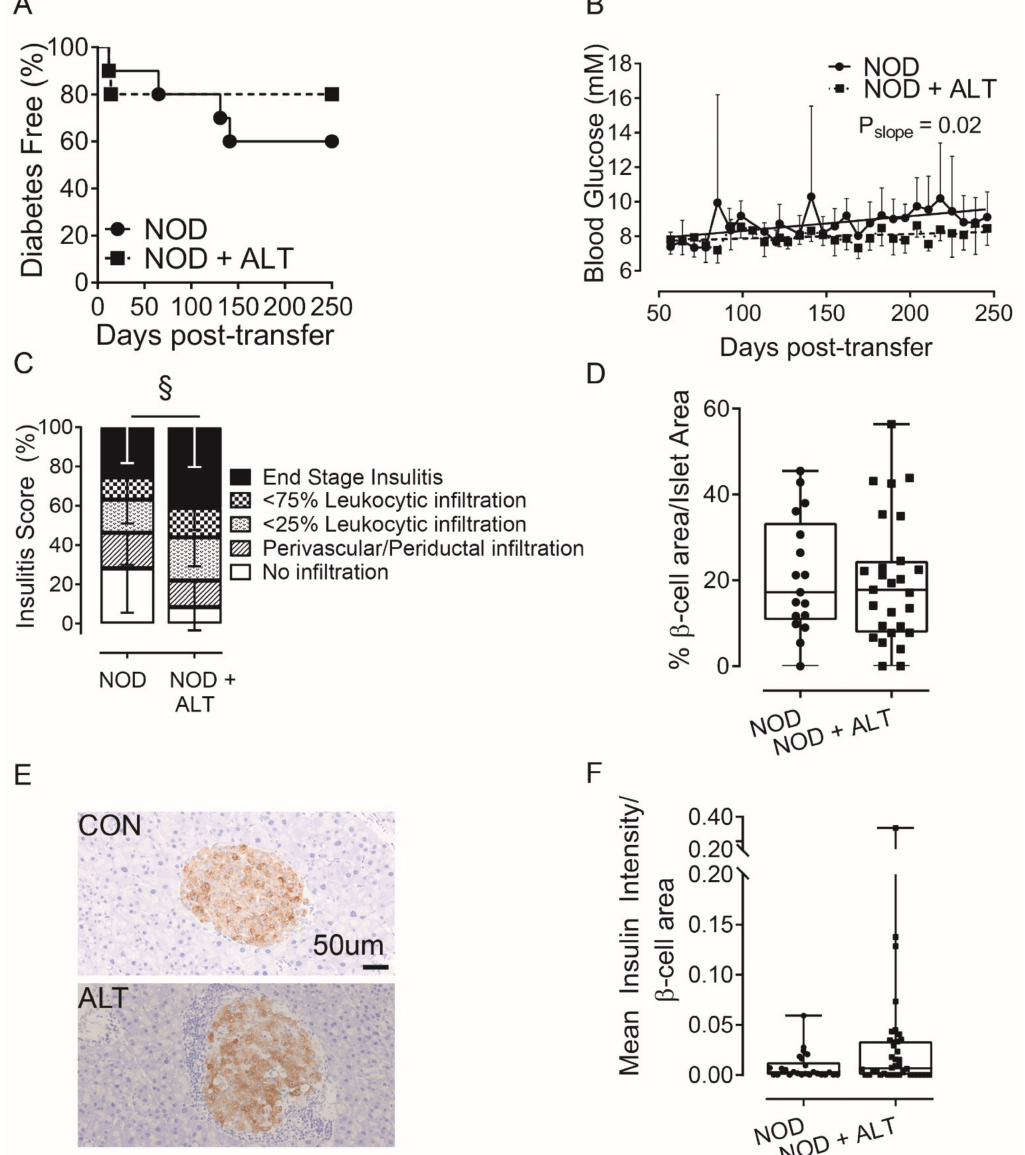
Figure 2. Alagebrium chloride delays diabetes development following adoptive transfer of G9C8 CD8 TCR transgenic cytotoxic lymphocytes. Diabetogenic splenocytes from NOD G9C8 CD8 TCR transgenic donors pre-primed with the aa15–23 of the insulin B chain (1 × 10 7 cells), were transferred into non-diabetic NOD ShiLt recipients ( n = 10/group; day 80 of life). NOD ShiLt recipients were pre-treated for 30 days with (NOD + ALT, 1 mg/kg/day, s.c; (cid:4) , dashed line) or without alagebrium chloride (NOD, • , solid line). The recipient mice were monitored daily, tested for blood glucose and diabetes diagnosed by two consecutive blood glucose measurements > 15 m · mol/L and followed until diabetes diagnosis or until study end (day 250). ( A ) Diabetes incidence in NOD ShiLt recipients post-transfer of G9C8 cells. ( B ) Linear regression of non-fasting blood glucose concentrations over time, difference of slopes p = 0.02. ( C ) Pancreatic immune cell infiltration at day 250 ( n = 6–8 mice/group), shown as mean percentage of islets with no infiltrate (white), perivascular/periductal infiltrate (striped), <25% infiltrate (arrowhead), <75% infiltrate (checkerboard) or end stage insulitis (black) of untreated splenocytes (CON; circles) or Alagebrium-treated splenocytes (ALT; squares) § p <0.0001, chi-square test. ( D ) β -cell area, determined from insulin IHC staining in ( E ) Representative images of islets detected with anti-insulin antibody in pancreatic sections taken from untreated (CON) or treated mice (ALT), scale bar = 50 µ m. ( F ) Pancreatic expression of insulin ( n = 26–40 sections/group, n = 2–39 islets/section, n = 6–8 mice/group, 5 µ m sections, 96 µ m apart. Data reported as either mean ± SD or box and whisker plots reporting median, interquartile ranges and min and max